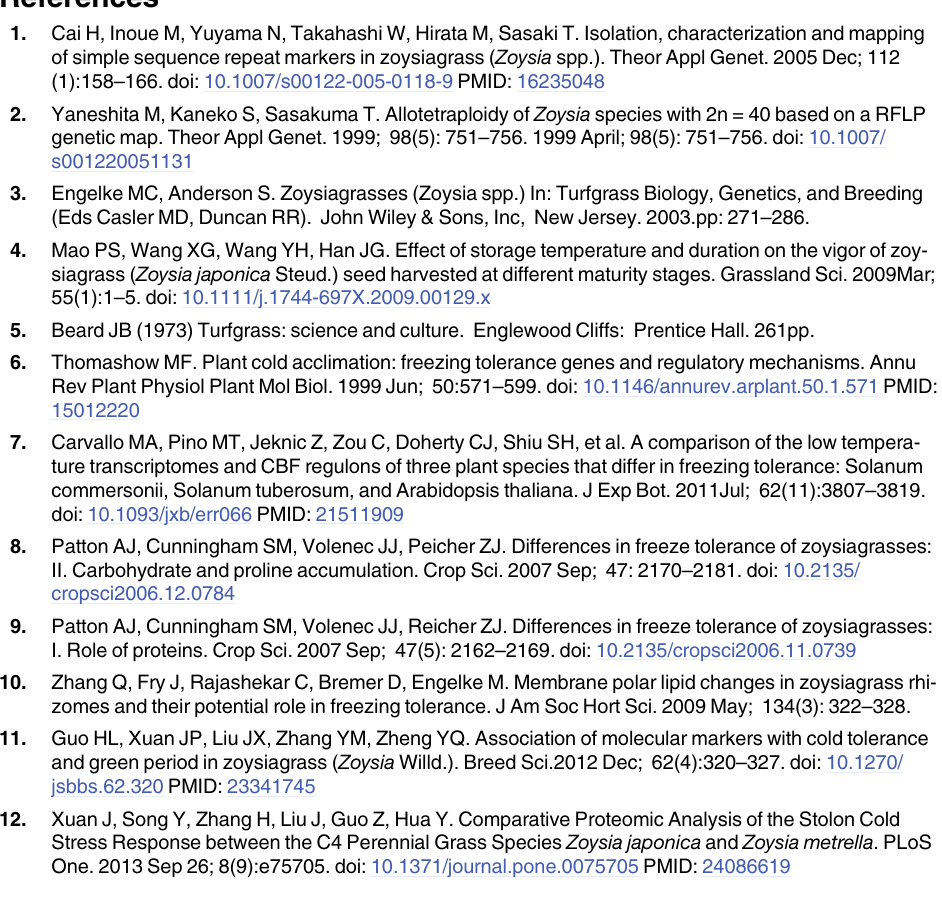
S10 Table. The expression changes of DEGs involved in desiccation stress and osmotic adjustment. S11 Table. The expression changes of DEGs in GO term of carbohydrate transport. S12 Table. The expression changes of DEGs related to plant hormone metabolism or stimu-